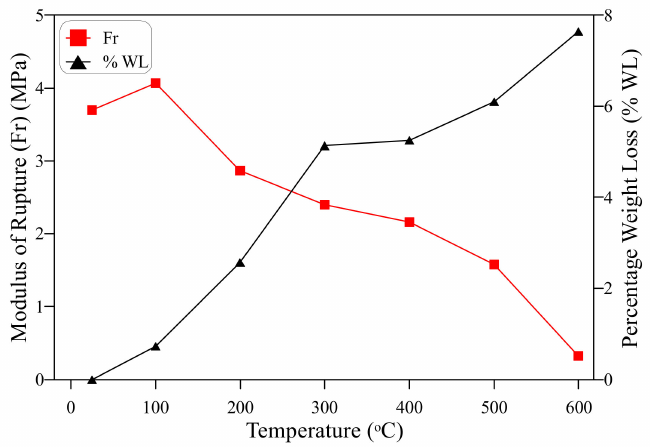
Figure 9. The relation of flexural strength and percentage weight loss of the prism specimens at different temperatures.